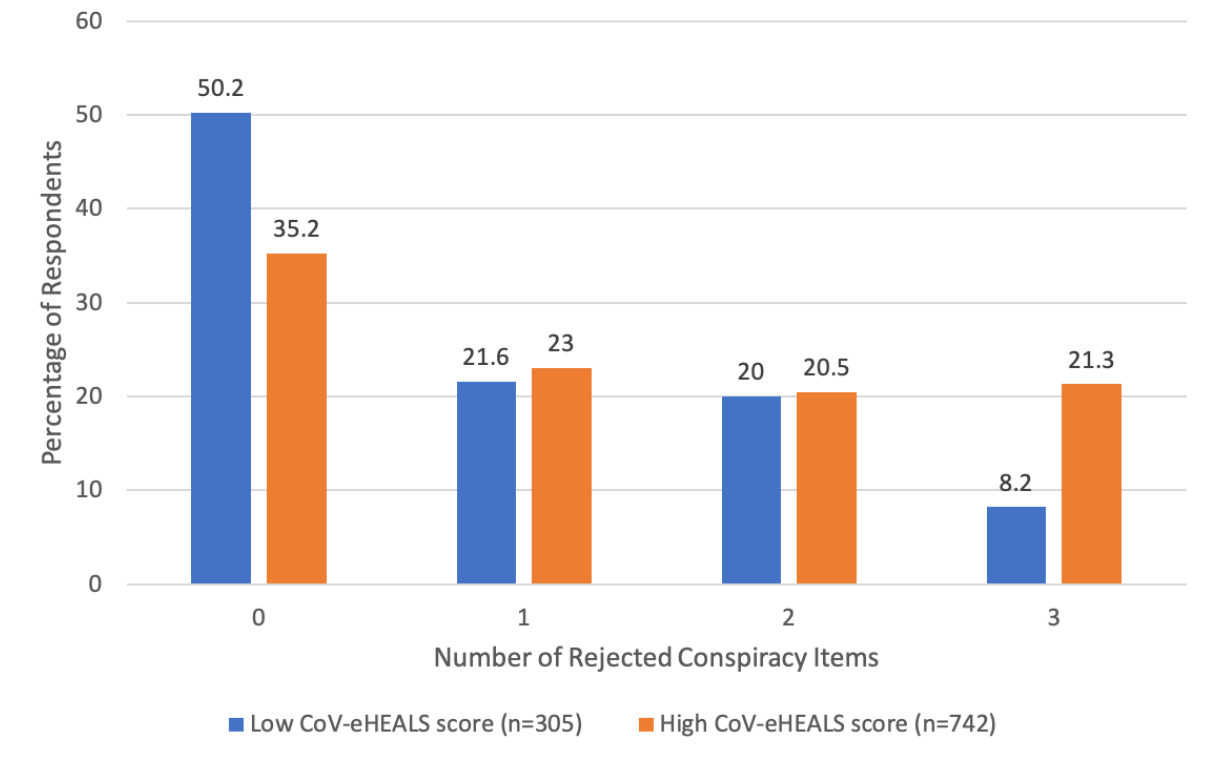
Figure 2. Number of rejected conspiracy items by coronavirus-related eHealth